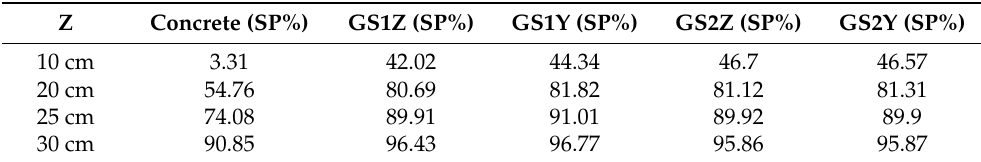
Table 2. Shielding percentage obtained from metamaterials and Table 2. S hielding percentage obtained from metamaterials and concrete.